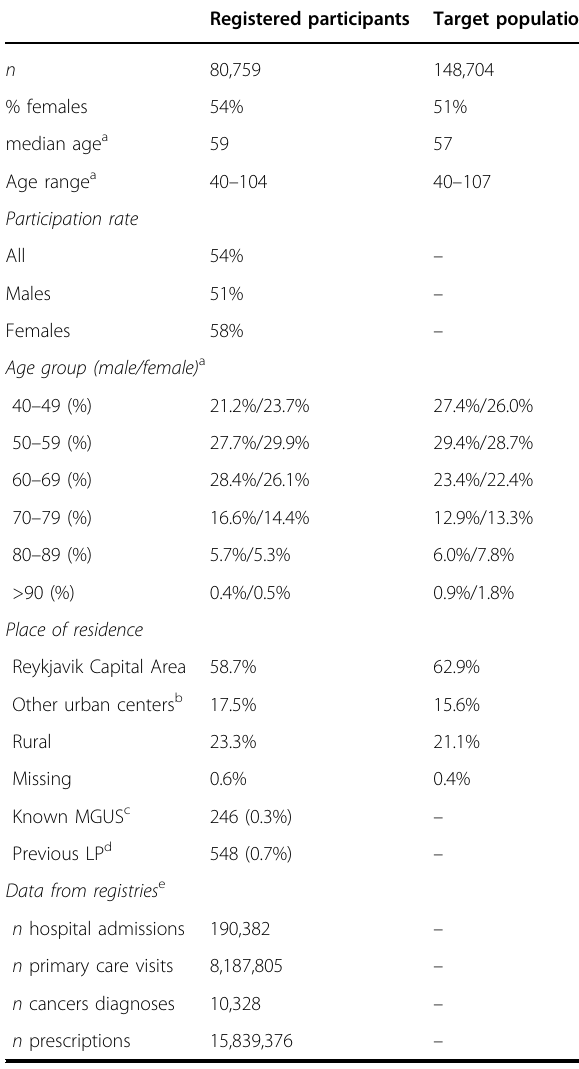
Table 4 The age, sex, and geographical distribution of participants and the target population, as well as available national registry data at the close of study